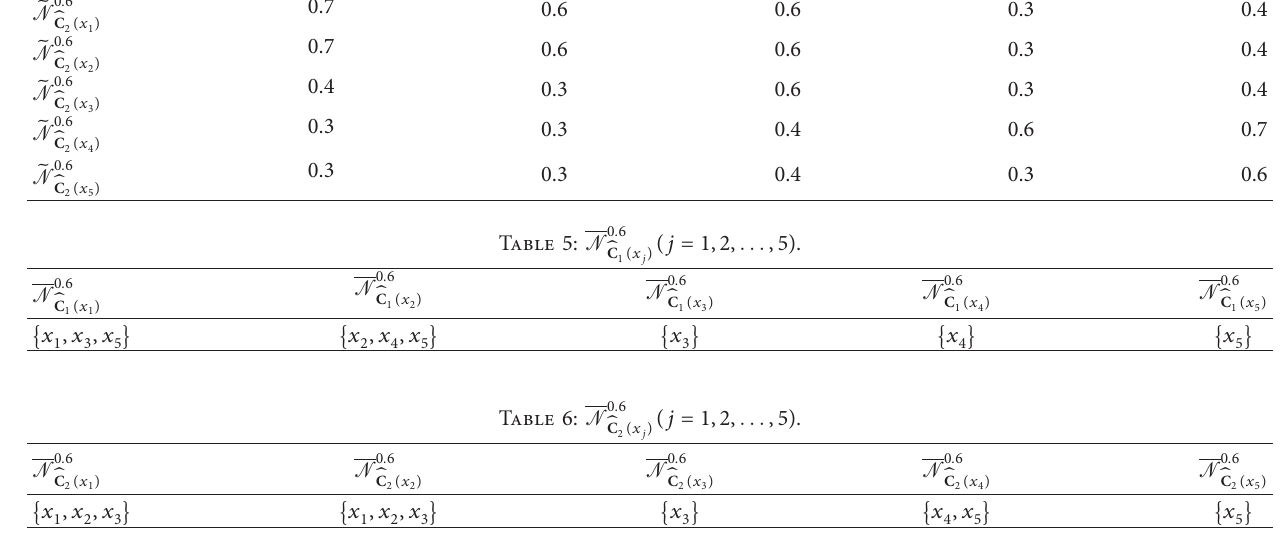
( j � 1 , 2 , ... , 5 ) C 2 ( x j )